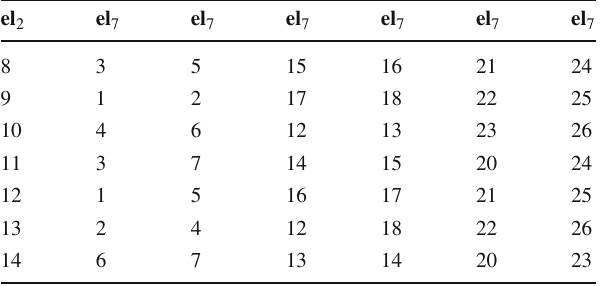
Table 3 Solutions for the charged-lepton mass matrix in terms of the order 7